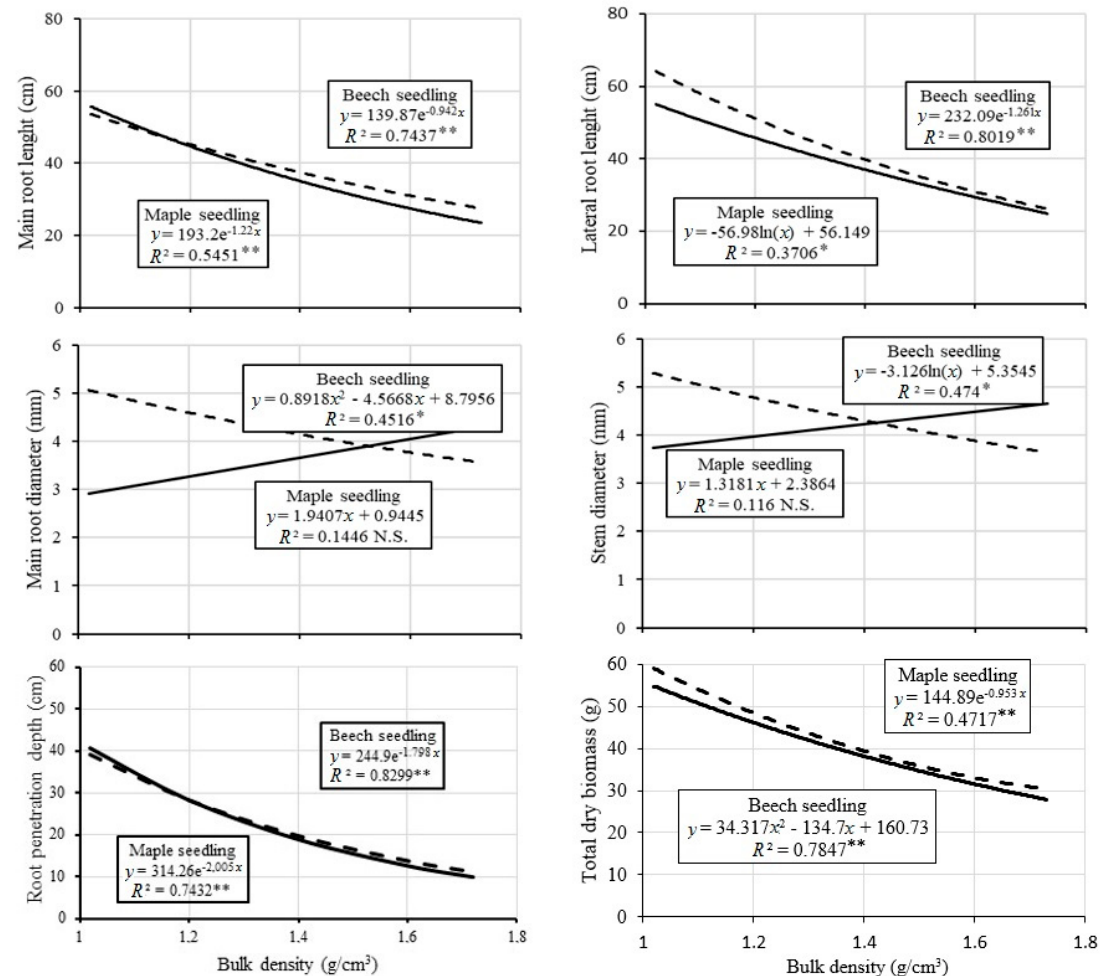
Figure 2. Relationship between bulk density and seedlings morphology and biomass; continuous line indicates maple behavior, and discontinuous line indicates beech